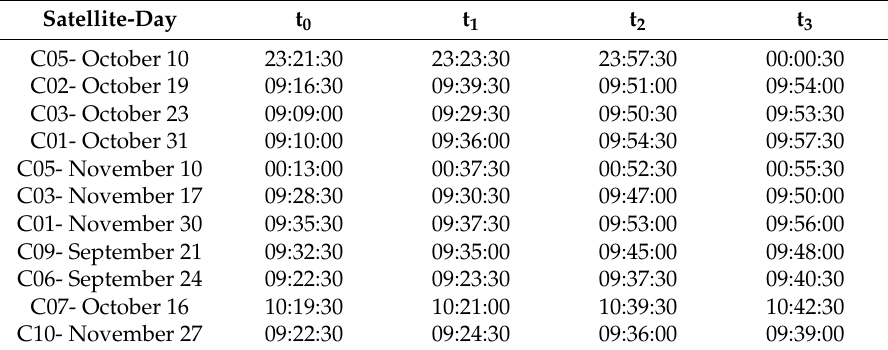
Table 6. Turning points of the studied maneuvering cases in September–November 2017.